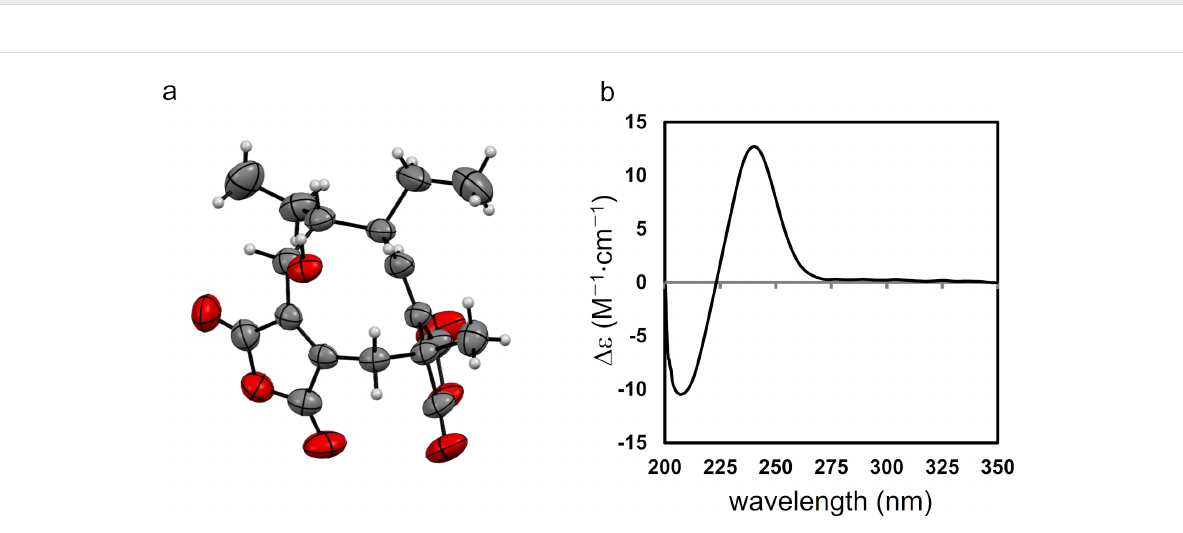
Figure 5: a) ORTEP drawing of 5 , with thermal ellipsoids indicating 50% probability. b) Electronic circular dichroism spectrum of 5